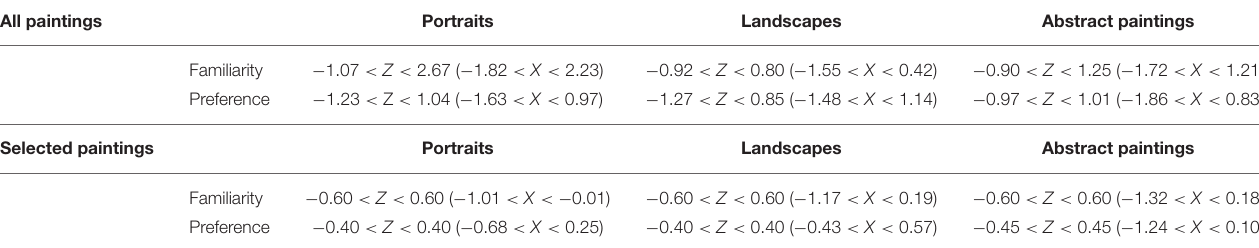
TABLE 1 | The ranges of Z-scores (raw scores) for all and the selected images of paintings in each category based on painting content. All paintings